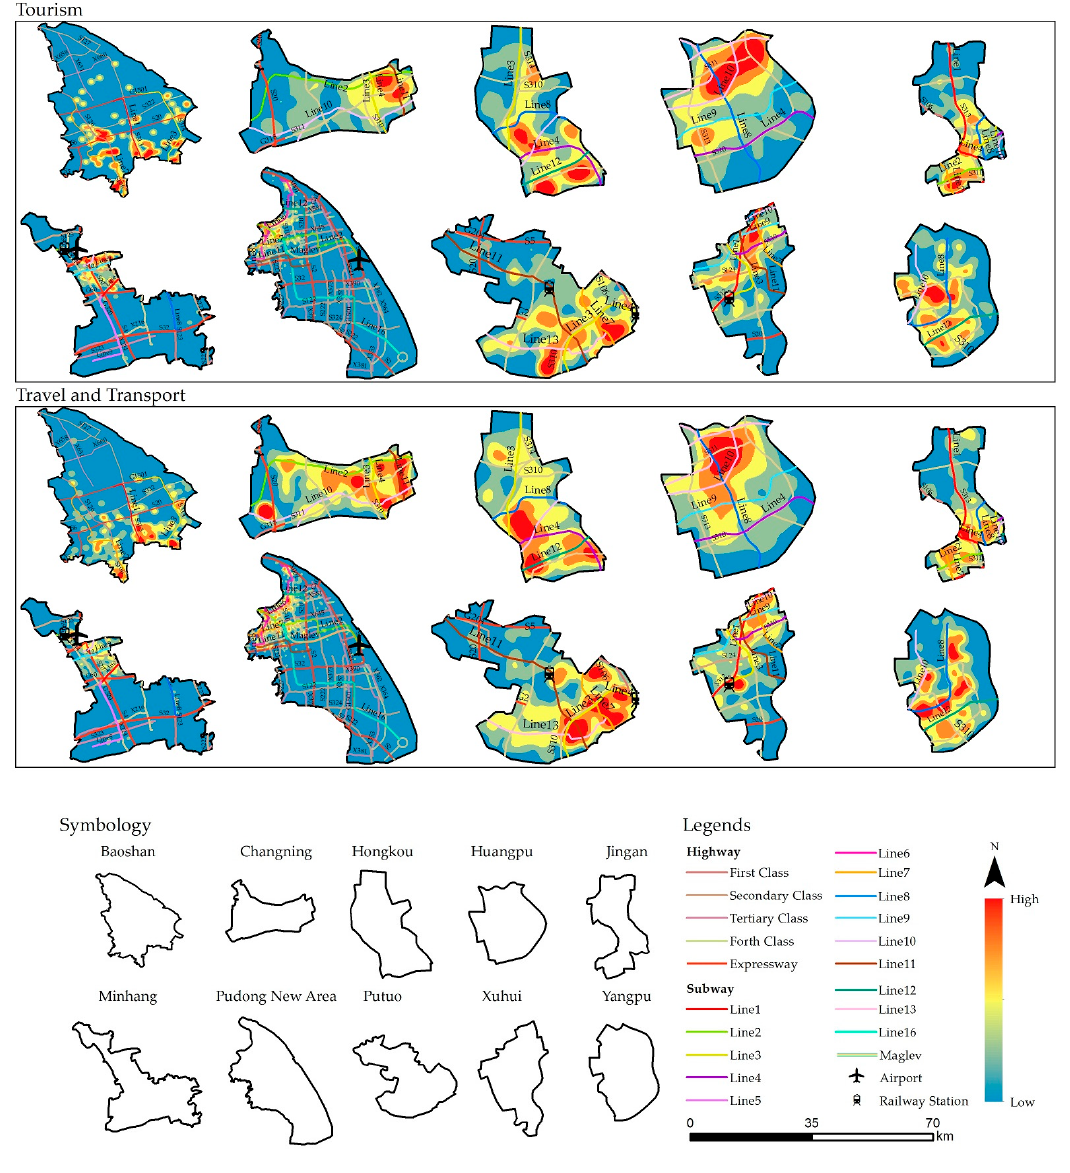
Figure 11. Kernel densities of activities in districts of Shanghai.